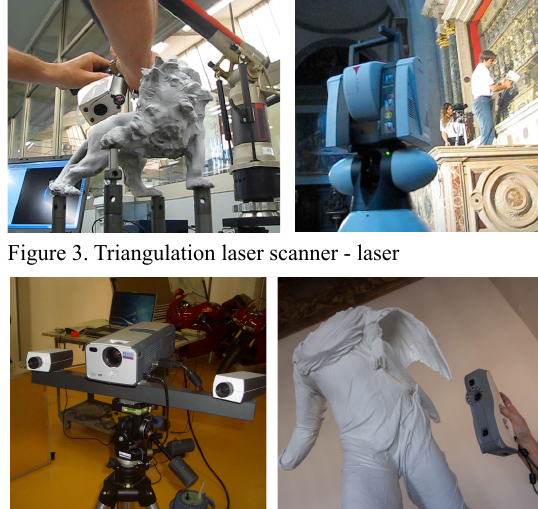
Figure 2. Phase Comparison laser